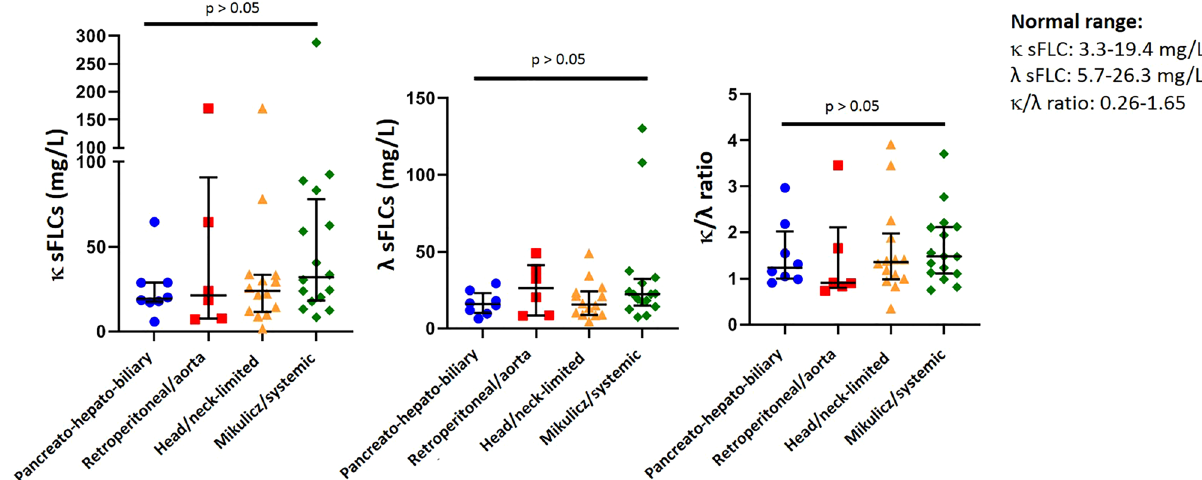
Figure 2. Levels of κ and λ serum free light chains and the κ/λ ratio were not different among pancreato- hepato-biliary (n = 8), retroperitoneum and aorta (n = 6), head and neck-limited (n = 14) and Mikulicz and systemic (n = 16) phenotypes (median with interquantile range). Statistics performed by Kruskal–Wallis test. sFLC serum free light chains.